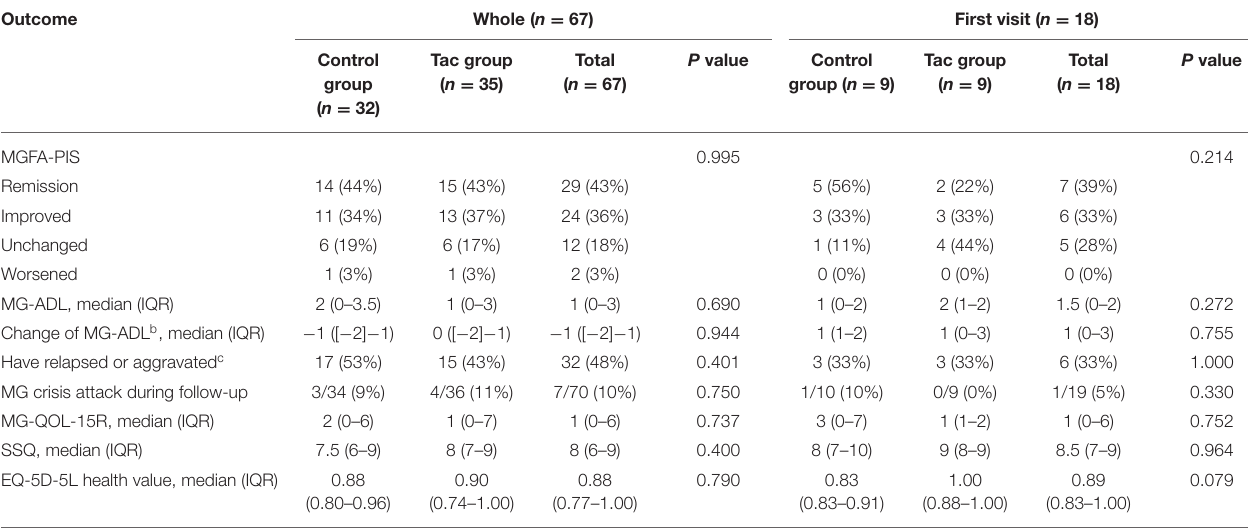
TABLE 3 | Outcome measurements of VLOMG patients in the whole cohort and subgroups a